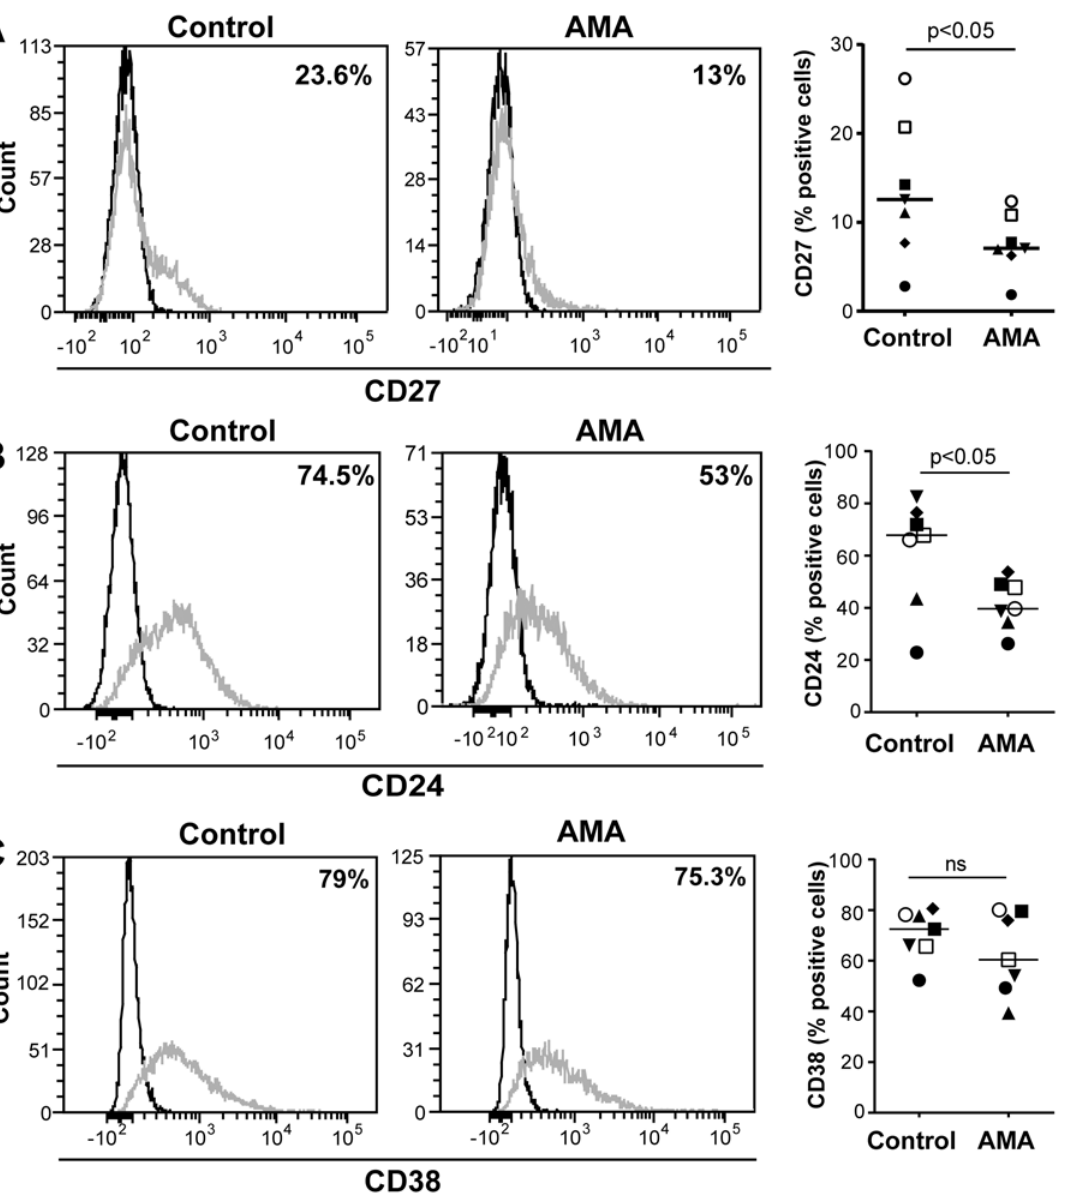
Fig 4. Surface markers of amastigote-stimulated B cells. Purified human B cells were incubated or not overnight with L . infantum amastigotes at a final parasite:host cell ratio of 3:1. Cells and the cell-parasite mixture were intensively washed with a galactose-modified PBS/EDTA solution and stained for CD27, CD24 and CD38. Dead cells were excluded by fixable viability dye staining. Representative histograms showing CD27 (panel A), CD24 (panel B) and CD38 expression (panel C) are shown on the left while percentages of positive cells are displayed on the right portion of the panel (n = 7). Dark lines on the histograms represent the FMO controls for each